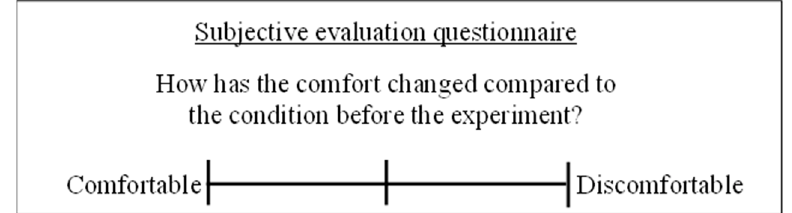
Figure 5. Questionnaire of experiment.